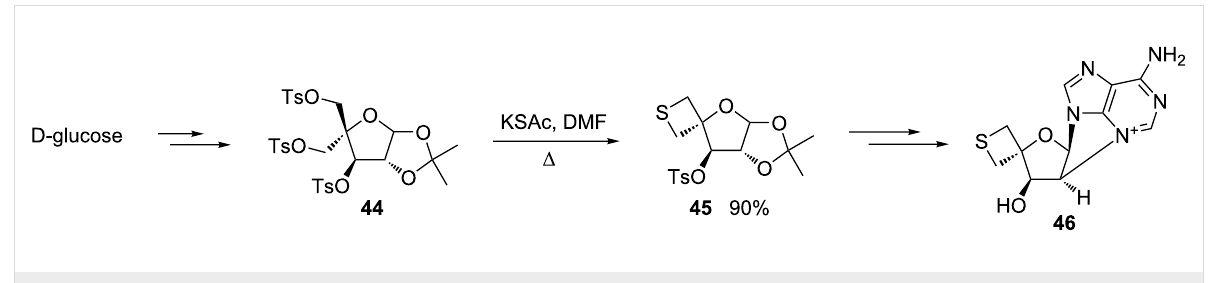
Scheme 10: Synthesis of a double-linked thietane-containing spironucleoside 48